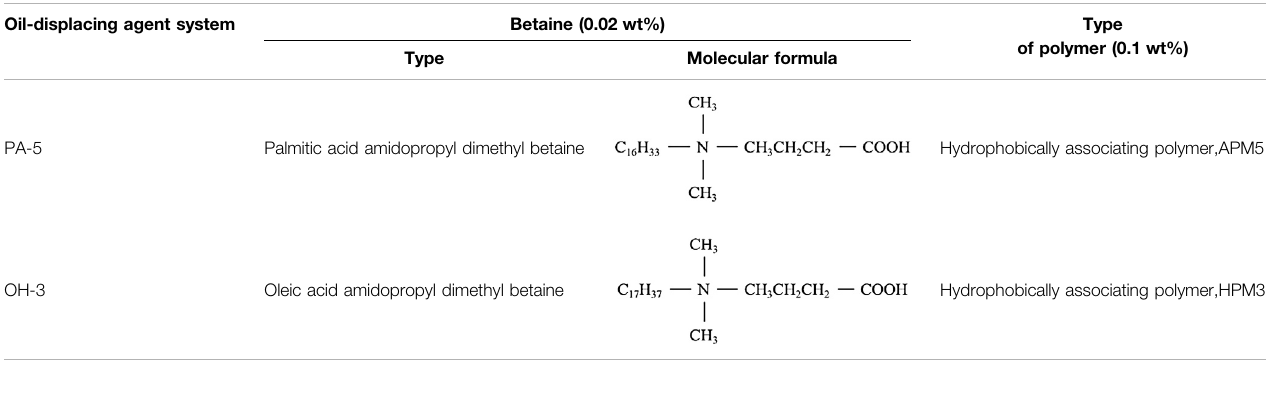
TABLE 2 | Composition of the oil-displacing agent system. Oil-displacing agent system